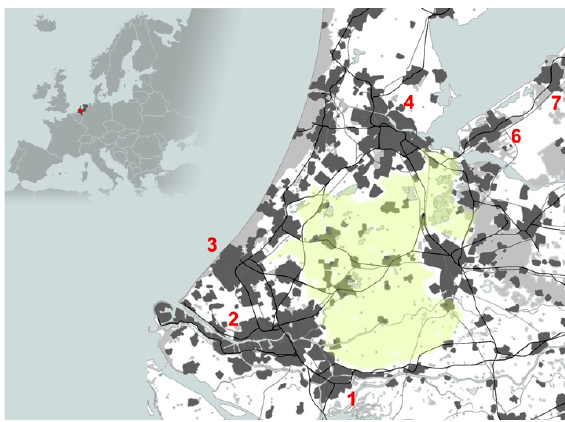
Figure 1. Randstad and Green Heart. Notes: (1) Dor- drecht, (2) Rotterdam, (3) Den Haag, (4) Amsterdam, (5) Utrecht, (6) Almere, and (7) Lelystad. Source: authors. To regulate the problem of overcrowding and congestion, it was proposed to keep buffers open between towns and cities, preserve a central open area, Green Heart ( Groene Hart ), and concentrate urbanisation in a limited number of locations elsewhere in the country. In 1960, the First National Spatial Planning Policy document sketched out